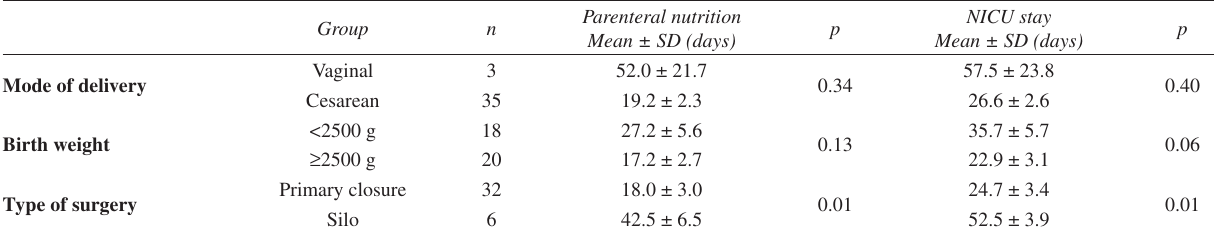
Table 3 - Association between mode of delivery, birth weight, and type of surgery with days of parenteral nutrition and NICU stay